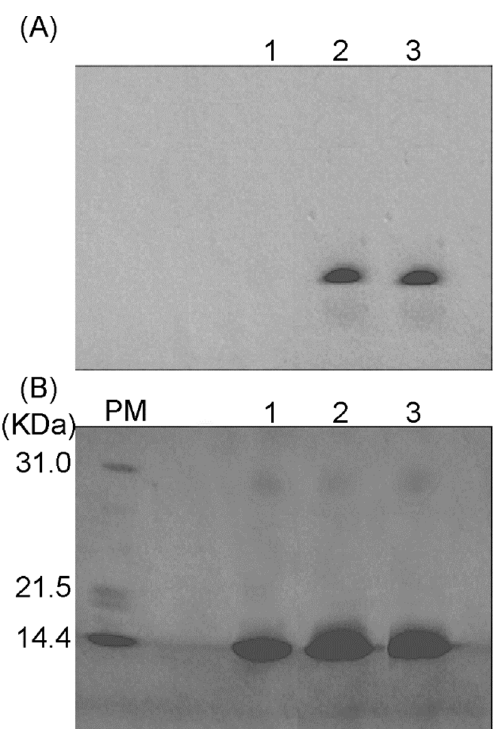
Figure 1. The UV-Vis spectra of the C14A mutant reconstituted with ( A ) ferrous and ( B ) ferric heme b . The spectra immediately after the reconstitution (red lines) show progressive blue shifts (blue lines) under ambient conditions.